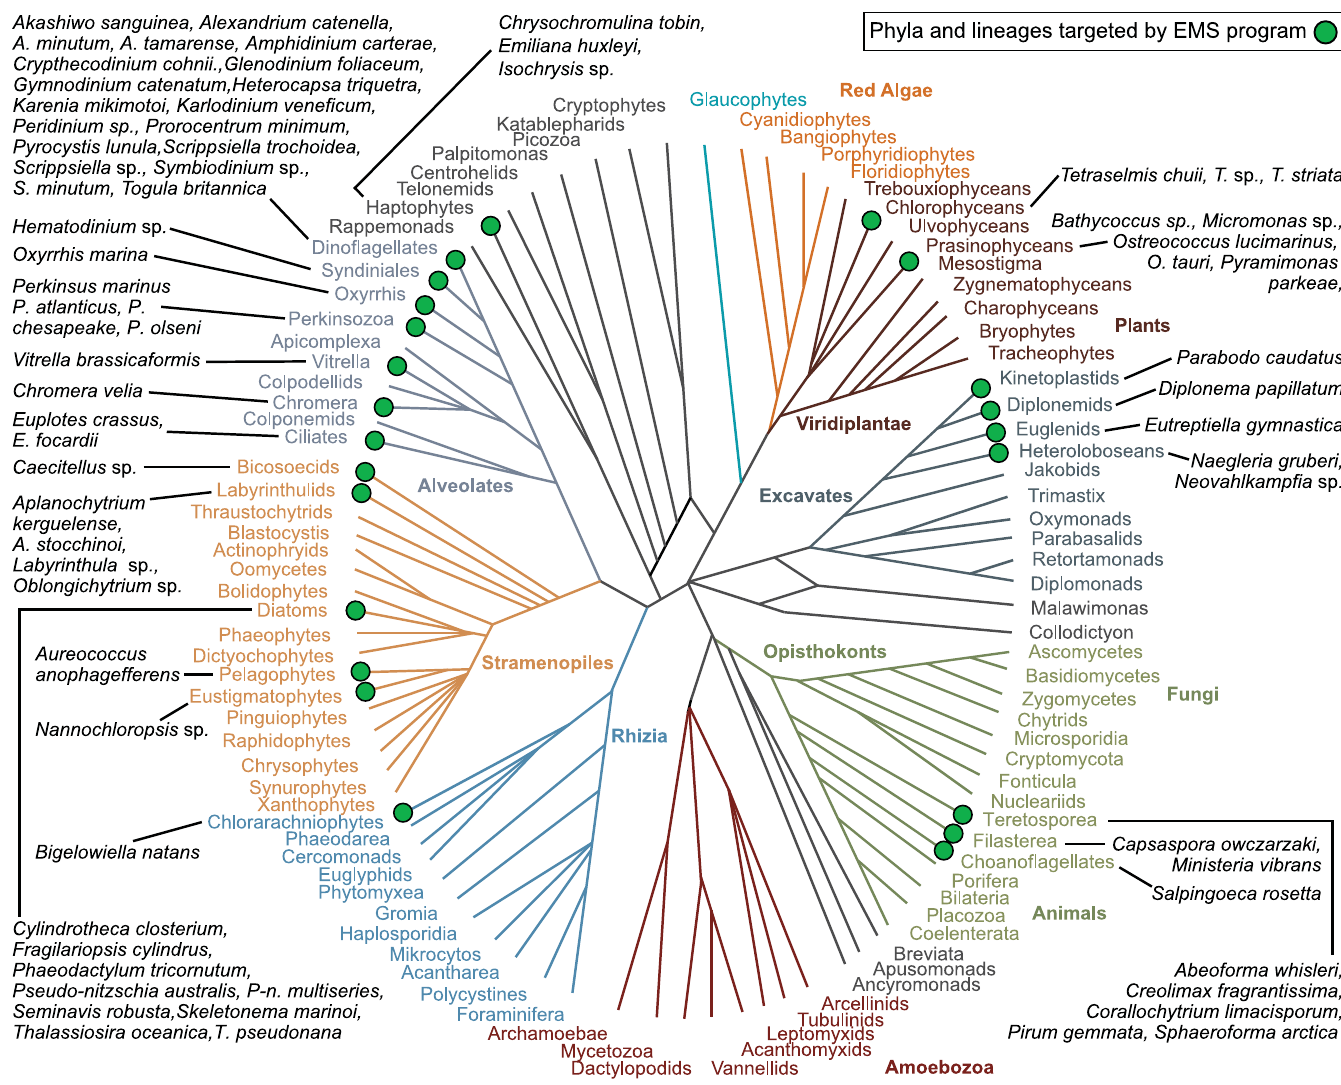
Fig 1. Schematic of relationships of major eukaryotic lineages with taxa the subjects of EMS projects indicated with green dots and listed in black text. The phylogeny is modelled on Keeling and colleagues (2014) [8]. EMS, Experimental Model Systems; sp., species.